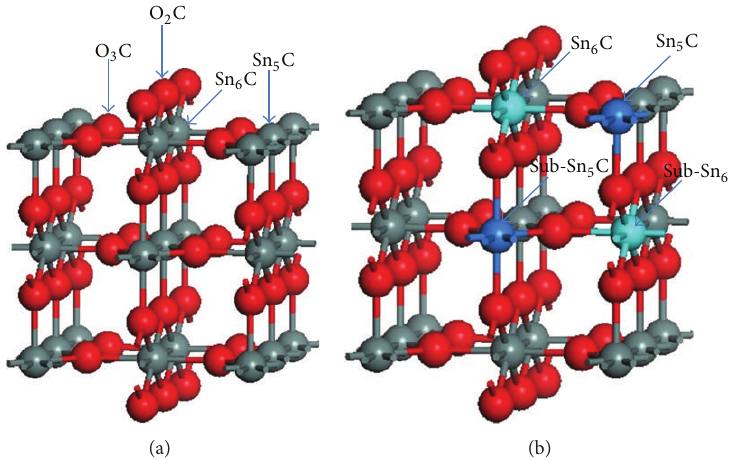
Figure 9: Schematic of (a) SnO 2 (110) surface model (b) doping and adsorption model.